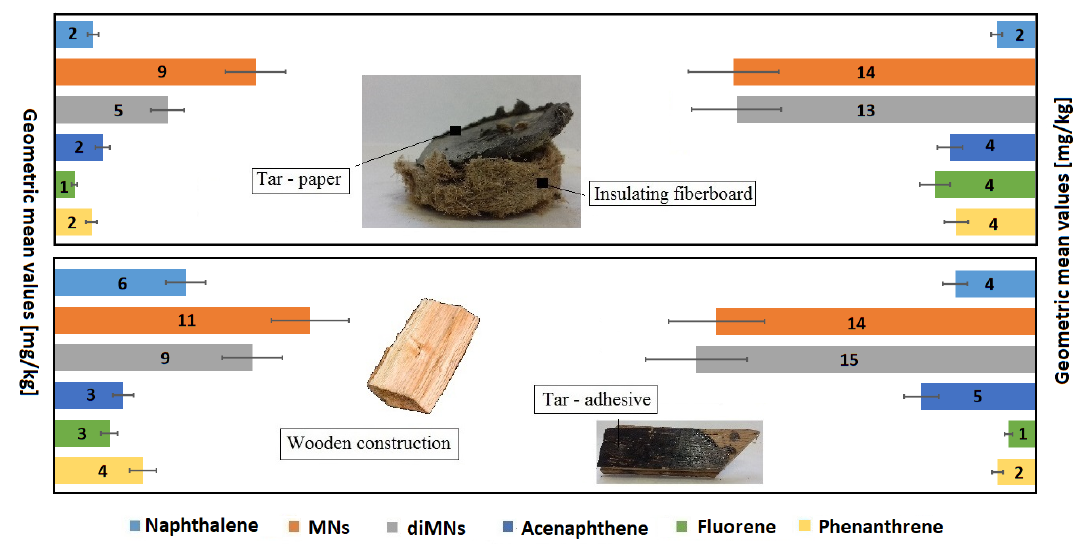
Figure 5. Emission of PAHs from samples of construction products taken from buildings intended for human habitation, where complaints about unacceptable hygienic conditions were raised.